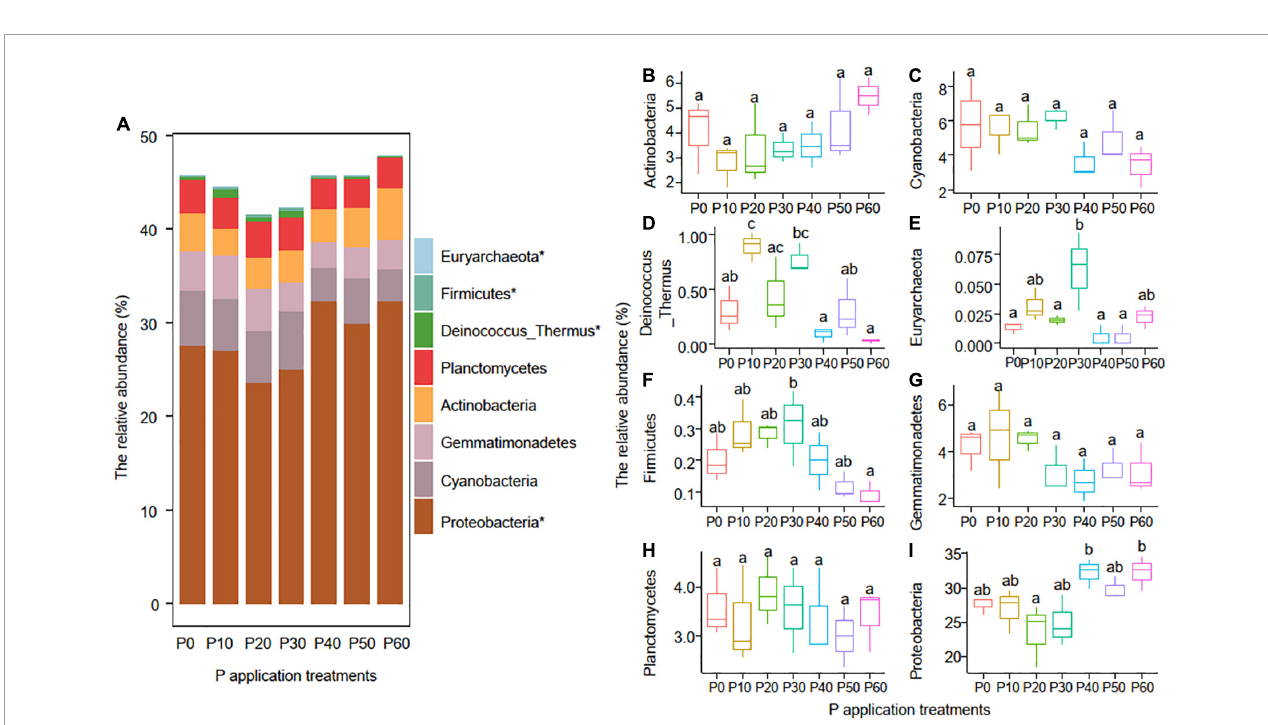
FIGURE2 The dominant phoD-harboring microbial phyla (A) and the variations of those dominant phyla [Actinobacteria (B) , Cyanobacteria (C) , Deinococcus_Thermus (D) , Euryarchaeota (E) , Firmicutes (F) , Gemmatimonadetes (G) , Planctomycetes (H) , and Proteobacteria (I) ] and P application rates. The asterisk (*) that follows the taxonomic name represents significant differences ( P < 0.05) among the seven